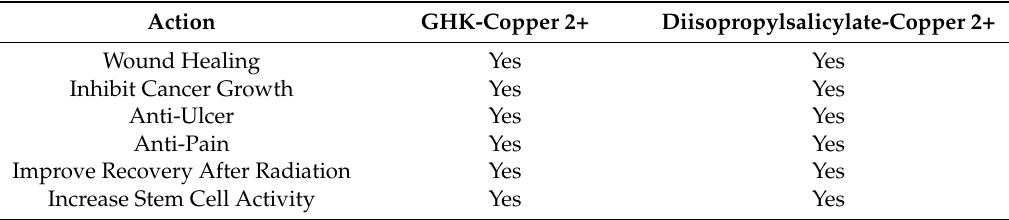
Table 1. Similarity of Actions of GHK-Copper and Diisopropylsalicylate-Copper.